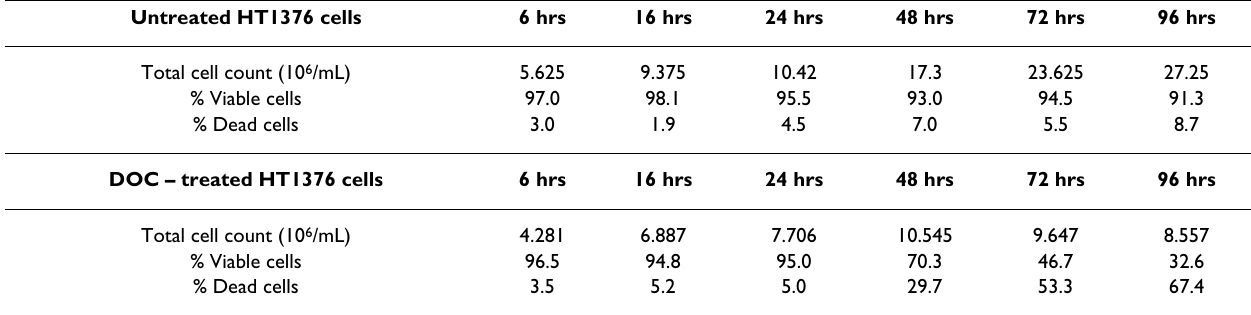
Table 4: Cell count and viability Untreated HT1376 cells